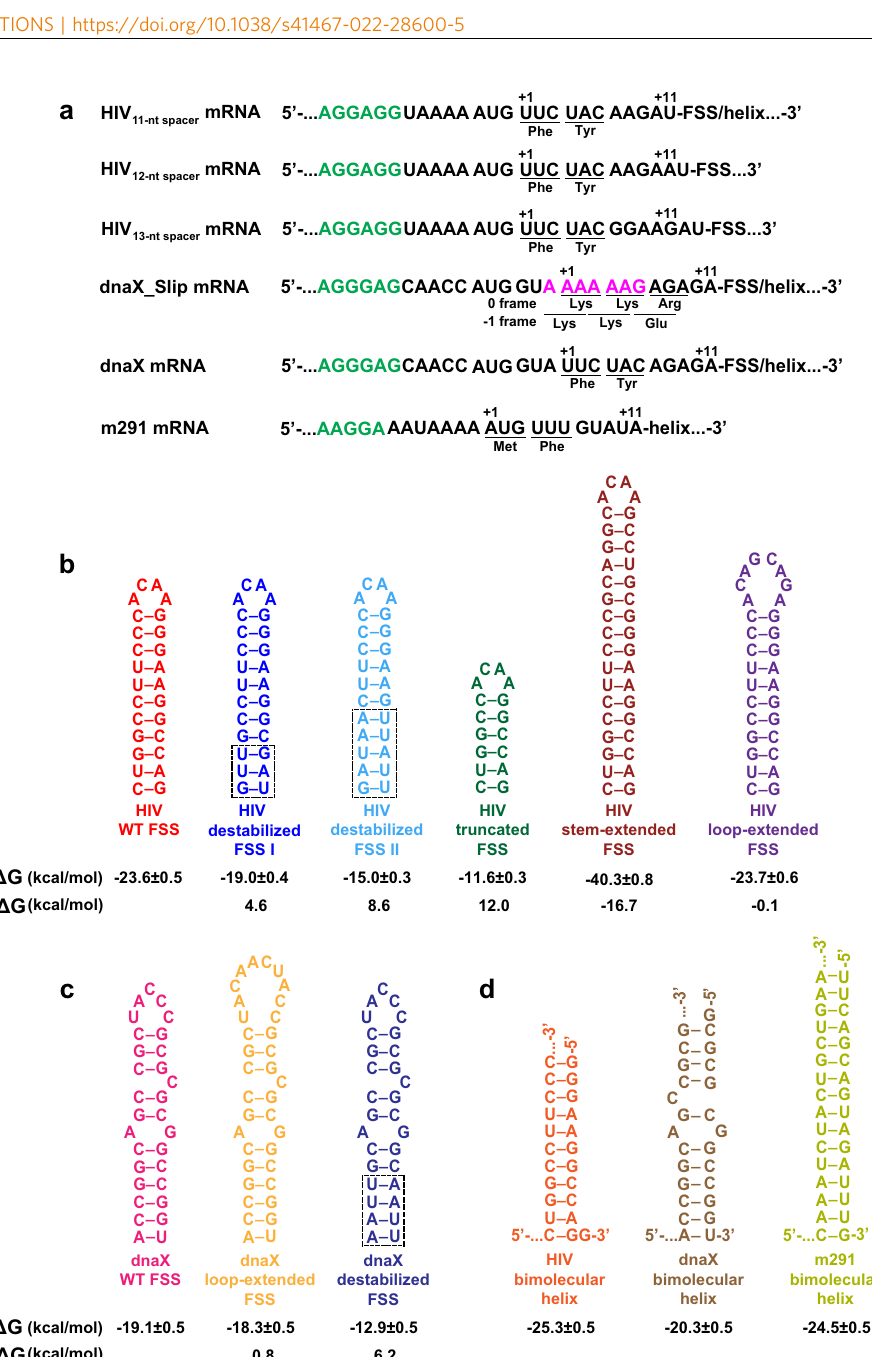
Fig. 1 Model mRNAs containing either an FSS stem-loop or a bimolecular helix. a Sequences of model mRNAs containing the Shine-Dalgarno (SD) sequences (green) and the FSS. The dnaX_Slip mRNA contains native slippery sequence (magenta). In other mRNA constructs, the slippery sequence is replaced with non-slippery codons. The fi rst nucleotide of P-site codon and the last nucleotide bound in mRNA tunnel are labeled + 1 and + 11, respectively. b – d Secondary structures of frameshift-stimulating stem-loops ( b , c ) or bimolecular RNA helices ( d ). Dashed boxes indicate replacements of native GC basepairs with less stable A – U or G – U pairs. Δ G ° values represent the overall thermodynamic stability of corresponding structures. ΔΔ G ° values of FSS variants indicate the changes in stabilities relative to the corresponding WT hairpins. Secondary structures and Δ G °/ ΔΔ G ° values ( b – d ) were determined by the RNAstructure software 45 using the default settings. Uncertainties in the folding free energy changes are determined using the variance and covariance of the nearest-neighbor parameter terms, determined by propagating the experiment uncertainties 62